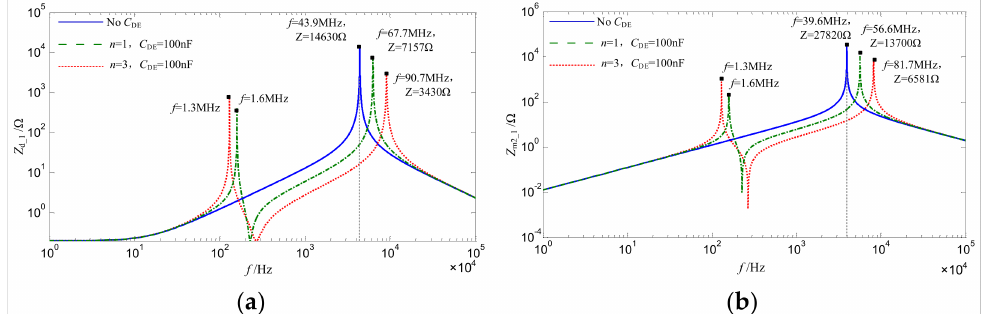
Figure 5. Amplitude–frequency curves of terminal impedances, Z d_1 and Z m2_1 , with different n values ( a ) at Stage 4 and ( b ) at Stage 7 and Stage 8.